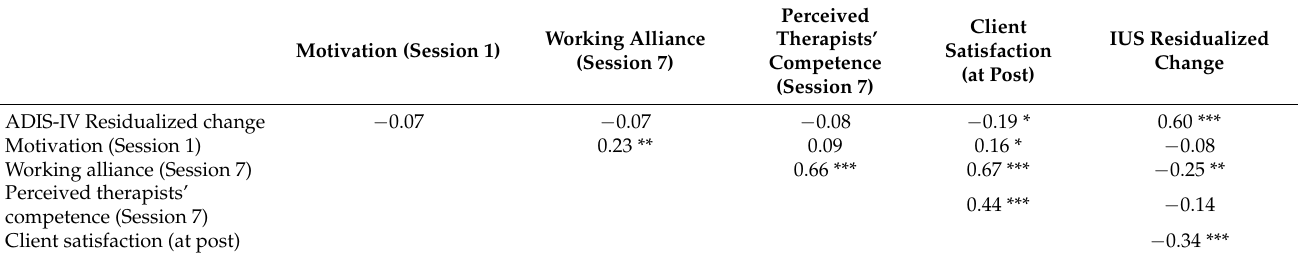
Table 6. Pearson correlations among the psychological variables used in the hierarchical